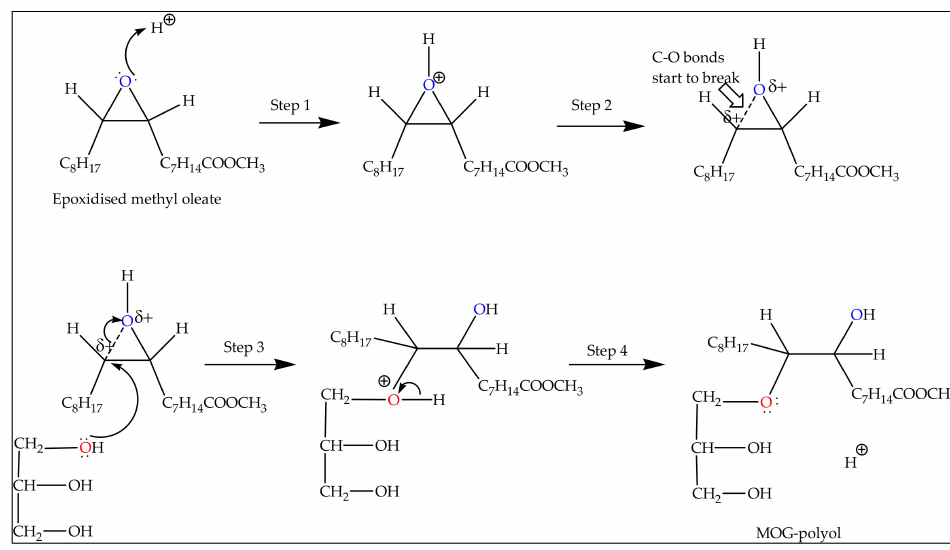
Scheme 2. Reaction mechanism of epoxide ring-opening reaction with